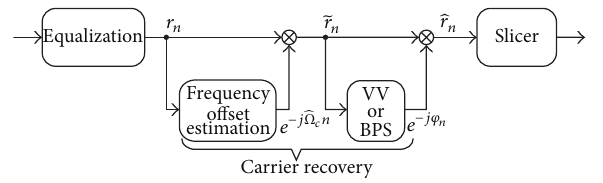
Figure 2: Simplified block diagram CPR based on BPS algorithm with frequency offset compensation.